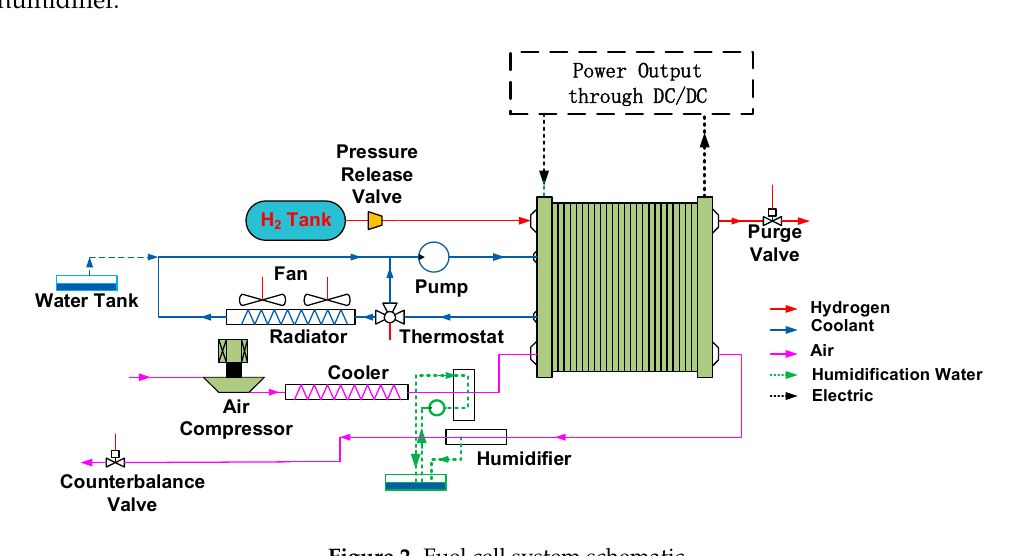
Figure 2. Fuel cell system schematic.